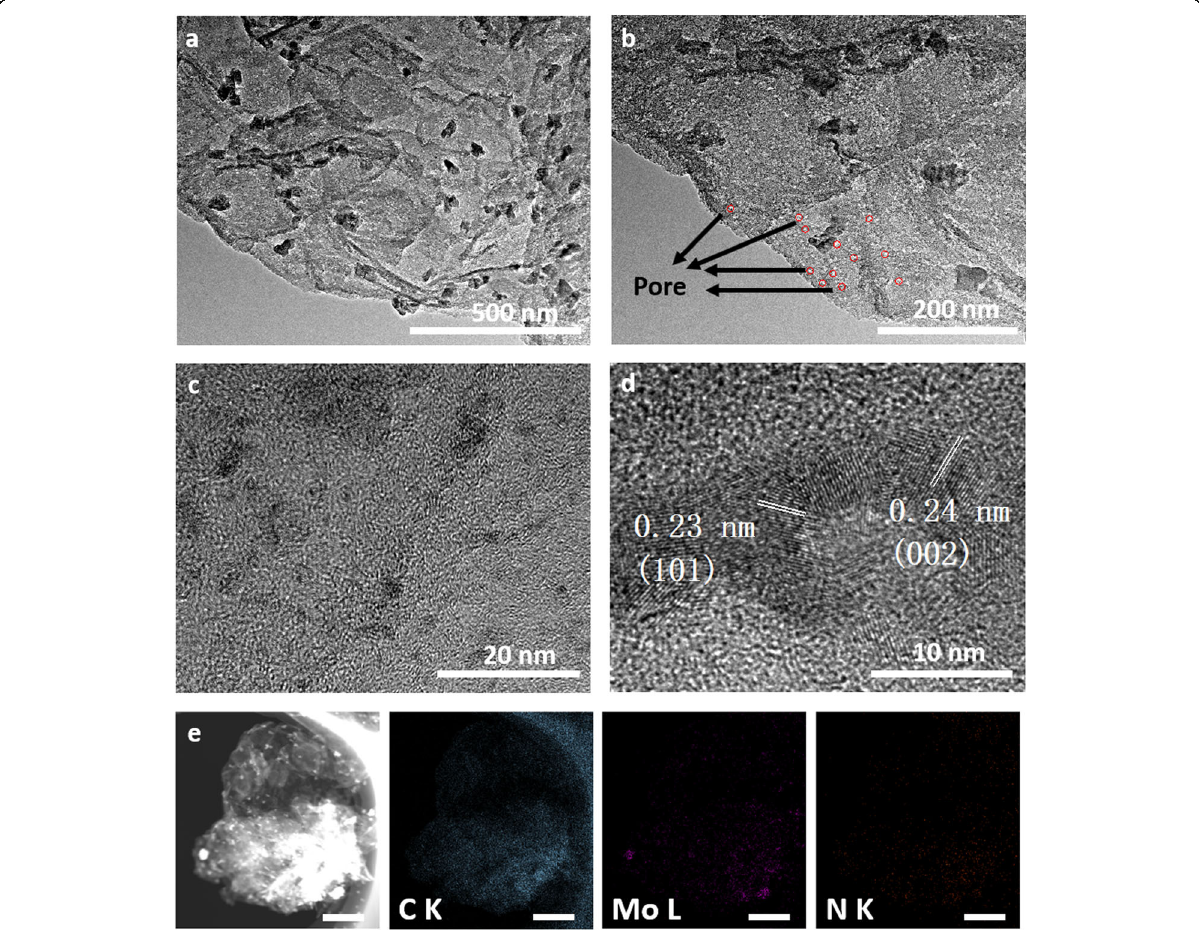
Fig. 3 The morphology of Mo 2 C/NPC. a – d TEM and HRTEM images at different magnifications and e corresponding EDS element mapping of Mo 2 C/NPC (scale bar 500